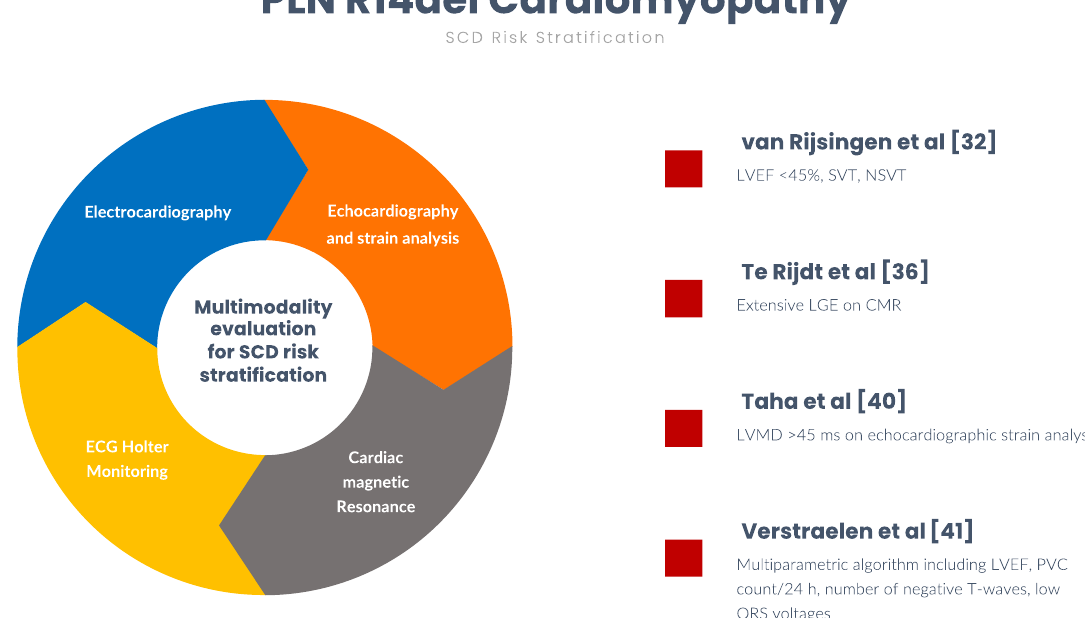
Figure 2. Risk stratification for sudden cardiac death in PLN R14del cardiomyopathy. CMR, cardiac magnetic resonance; ECG, electrocardiography; LGE, late gadolinium enhancement; LVEF, left ventricular ejection fraction; LVMD, left ventricular mechanical dispersion; NSVT, non-sustained ventricular tachycardia; PVC, premature ventricular contraction; SCD, sudden cardiac death; SVT, sustained ventricular tachycardia.